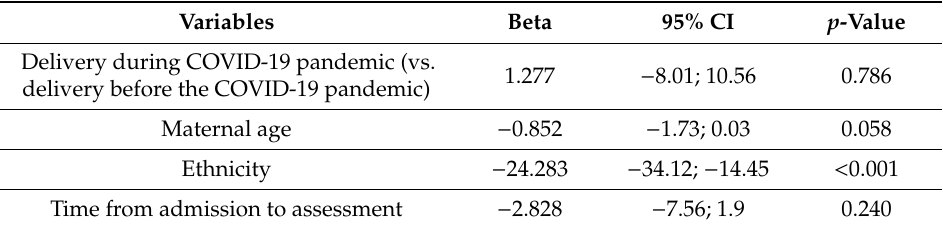
Table 6. Multivariable regression model for the association between delivery during COVID-19 pandemic and maternal objective cognitive test